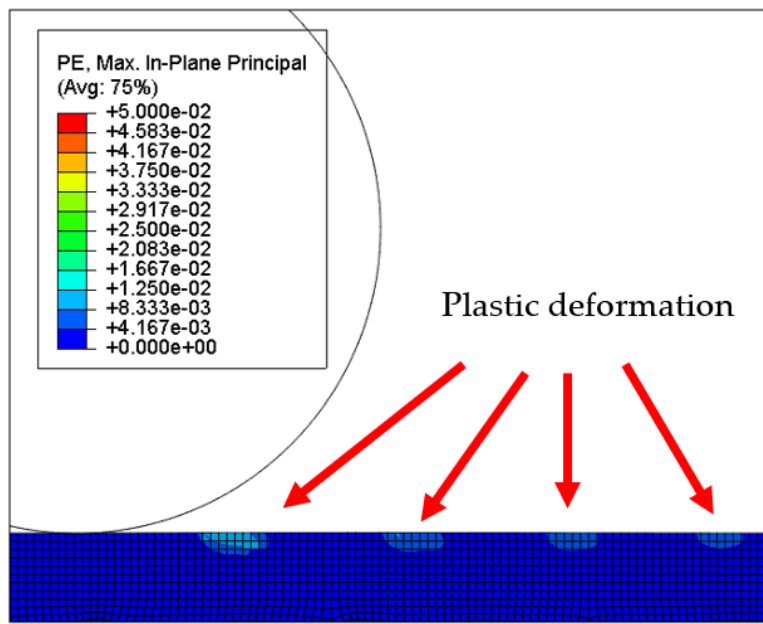
Figure 10. Plastic strain map of the 20 nm high tool mark surface.